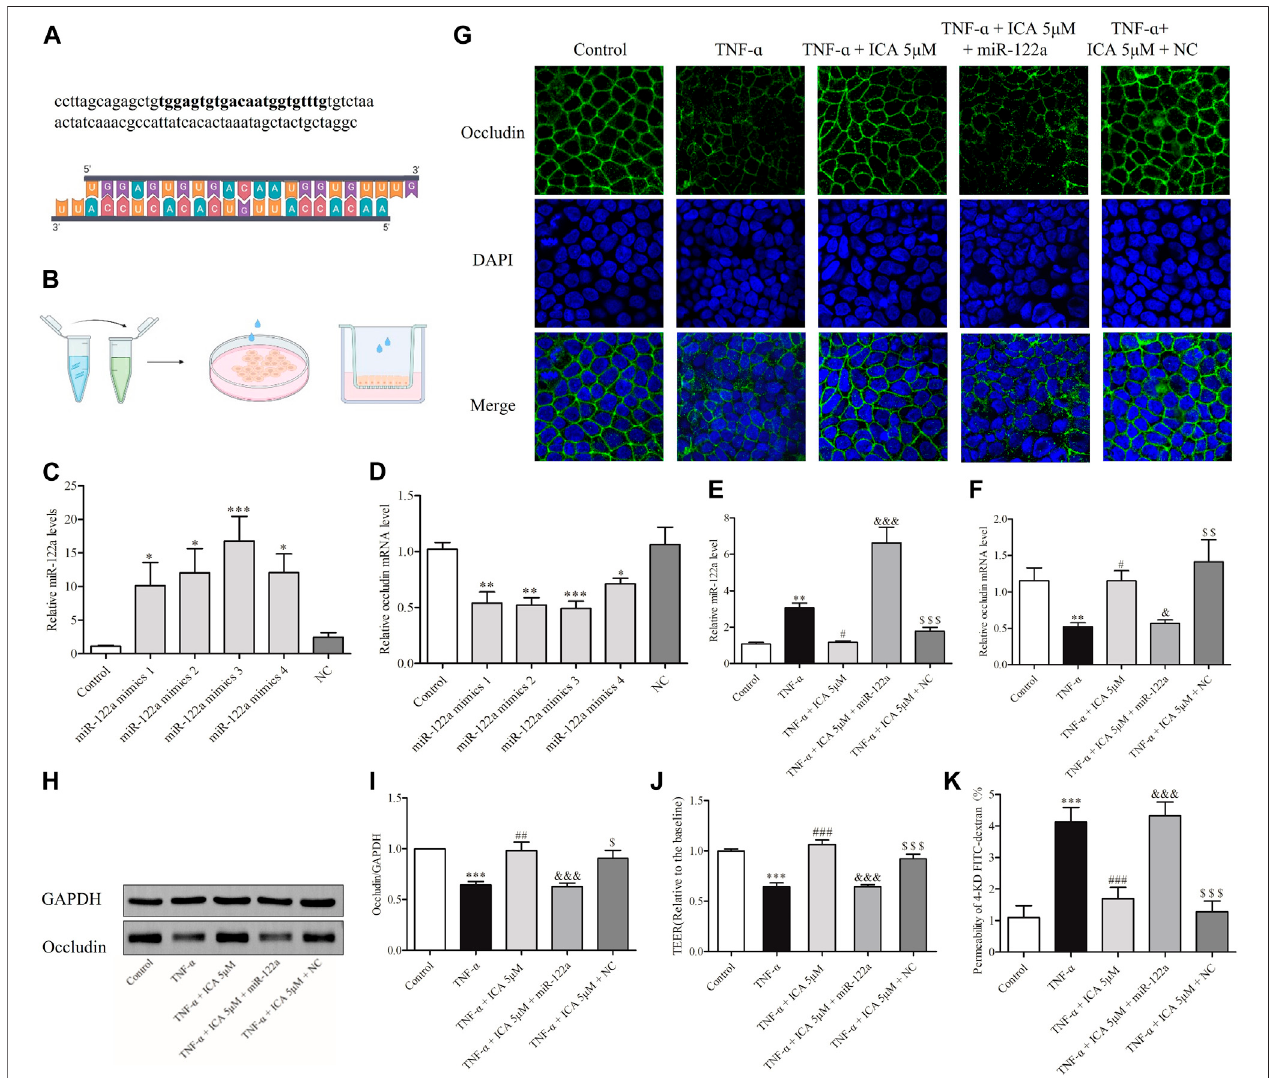
FIGURE 8 | In Caco-2 cell monolayers, transfection of miR-122a mimics reversed the down-regulation protection of ICA against TNF- α -induced Occludin and induced improved permeability. (A) miR-122a mimics were designed based on the miR-122a gene. (B) Schematic diagram of transfection of miR-122a mimics in the PetridishandTranswellCaco-2cells.Effectsofdifferenttransfectionconcentrationsontheexpression levelsof (C) miR-122aand (D) OccludinmRNAinCaco-2cellsin the Petridish. Changes in (E) miR-122a and (F) Occludin mRNA expression levels in cell monolayers. The miR-122a mimics group and the NC group were treated by transfecting miR-122a mimics or NC RNA for 24 h, and then treat with ICA and TNF- α . Changes in Occludin protein expression in Caco-2 cell monolayers were detected by (G) IF and (H,I) Western blot. Changes in permeability of Caco-2 cell monolayers were detected by (J) TEER and (K) 4-KD FITC-dextran. * p < 0.05